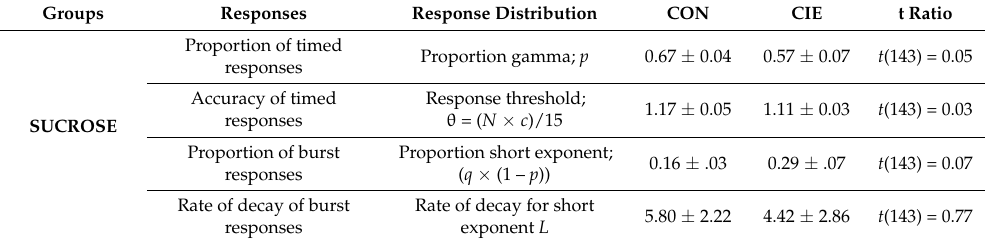
Figure 3. Interresponse time (IRT) distribution during DRL15 at Week 11 was unaffected in the SUCROSE-CIE group. No difference in the IRT distribution between the SUCROSE-CIE group (open red circles) and SUCROSE-CON group (open blue circles) was observed at Week 11. The data are expressed as mean ± SEM for percent reinforcers earned/responses emitted. n = 7–8/group. Table 2. Mathematical modeling parameters for sucrose-reinforced DRL responding. Table 2. Mathematical modeling parameters for sucrose-reinforced DRL